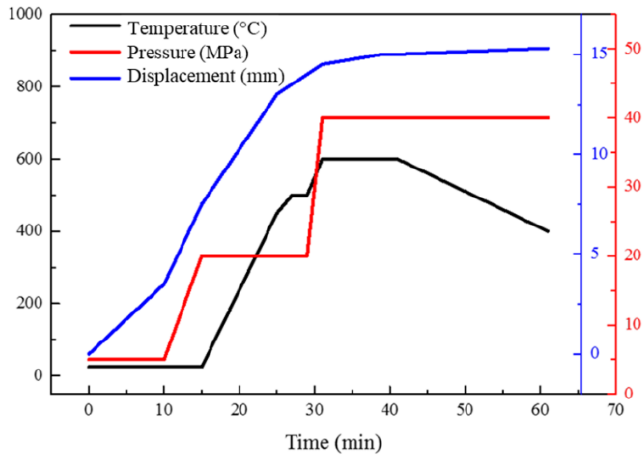
Figure 3. Actual temperature-time and displacement-time curves of the AlN/Al composites.